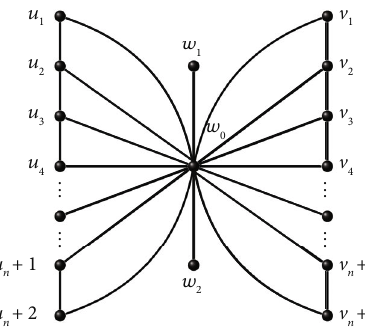
Figure 4: Total product cordial labeling of Dg